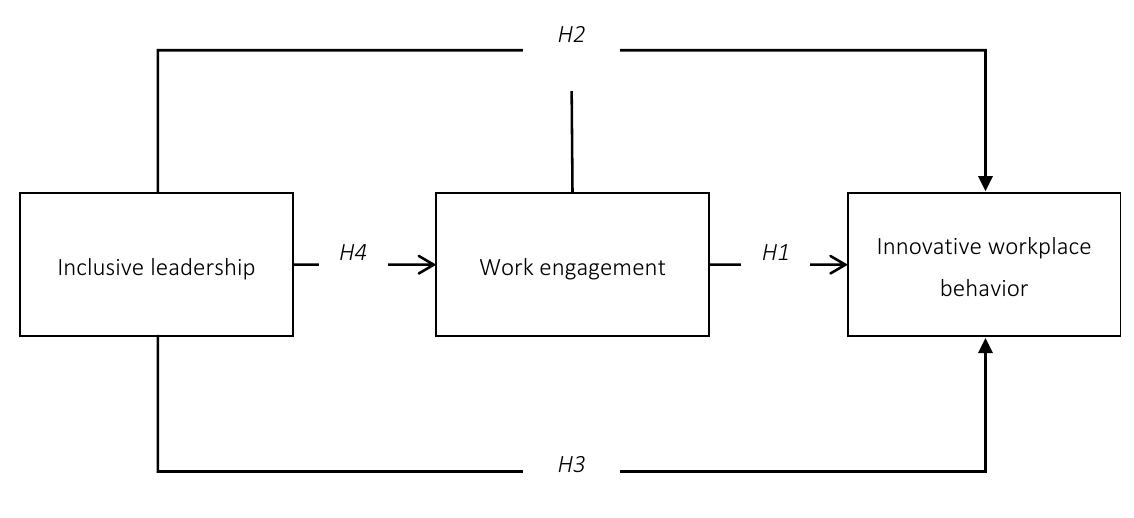
Figure 1. Research